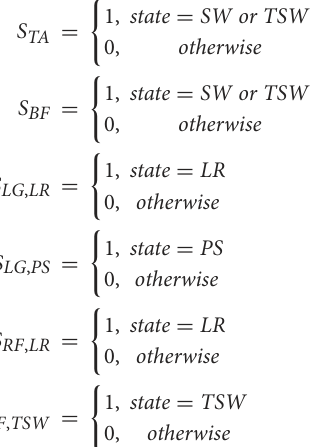
transitions, and H is the transfer function that generates the response output by convolving with the impulse input I . The the maximum threshold current amplitude that can produce a maximal muscle contraction without any discomfort, and C min visible muscle contraction. The values of C max and C min for each muscle were measured in a preparation experiment for every participant, detailed in Appendix 1